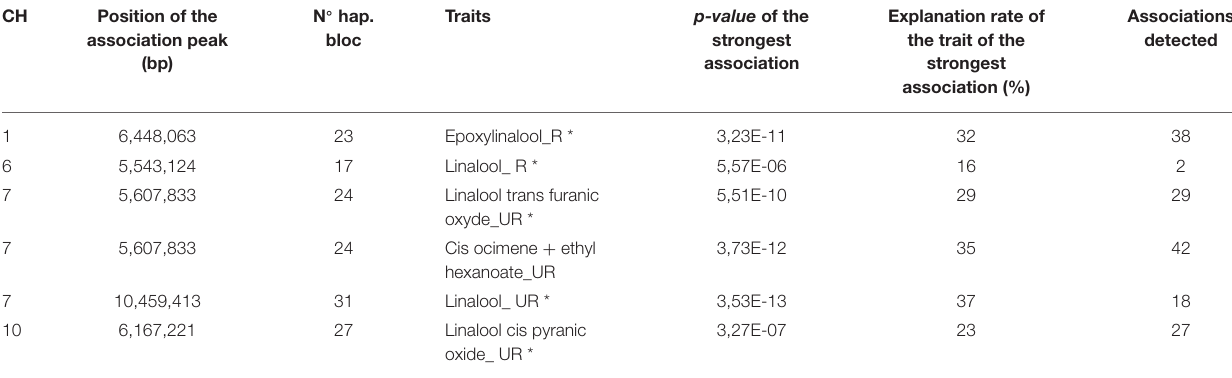
TABLE 3 | Most significant associations for biochemical compounds related to terpene